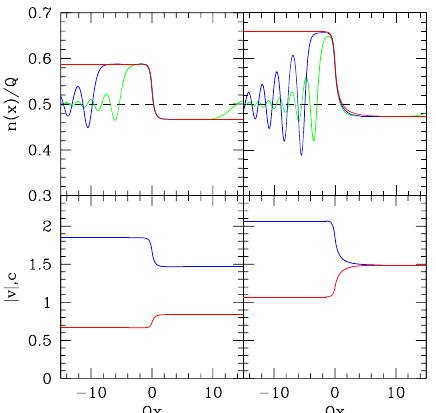
Figure 8. Top panels: time evolution of the density profile according to the GPE dynamics for a right Q . The dashed line shows the initial condition. Green, blue and red lines moving fluid with k F = π 2 Q (left panel) and k 0 = − k F correspond to evolution times t = 5,10,50 respectively for k 0 = − 3 π 10 (right panel). The time unit is τ = m . Lower panels: fluid velocity (red) and sound speed (blue) ¯ hQ 2